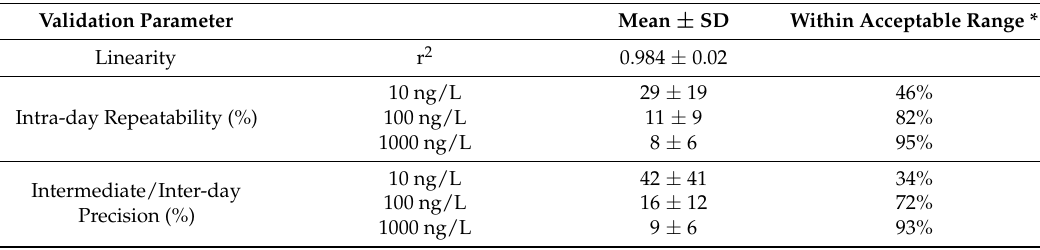
Table 2. Statistical overview of method validation showing the mean value and standard deviation (SD) for each parameter and the percent of determinations which fall between the acceptable range employed by U.S. Geological Survey (USGS) Method No.